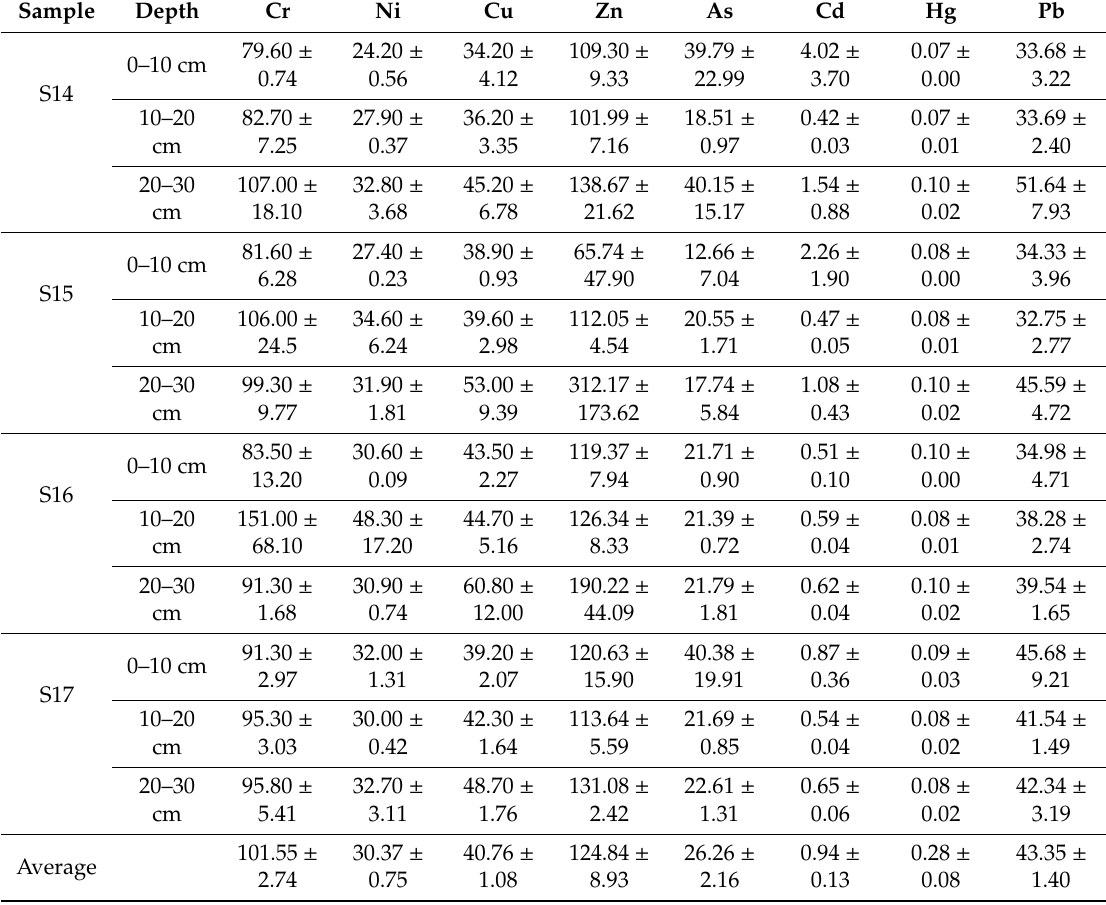
Table 5. Mangrove soil-borne trace elements (mg / kg) in the lower intertidal zone.